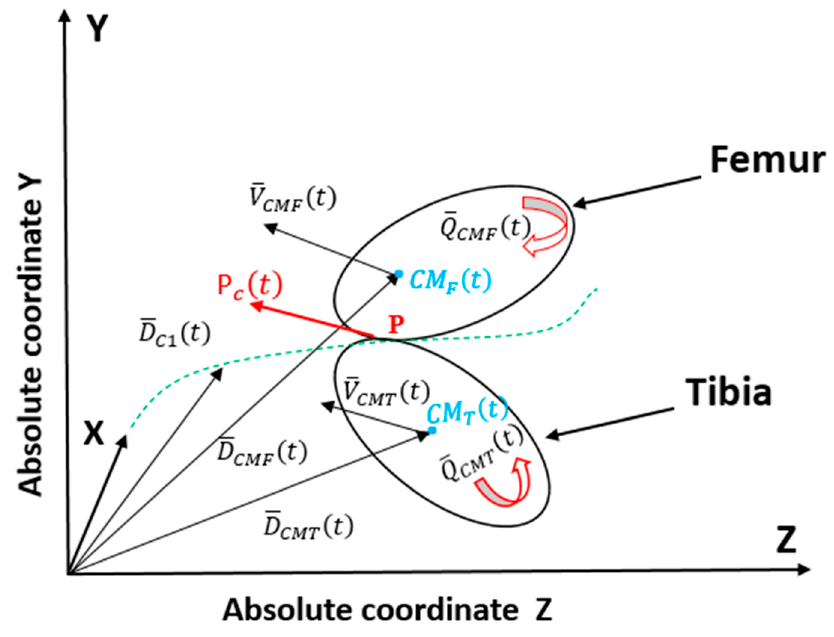
By substituting Equation (5) into (4), we obtain: